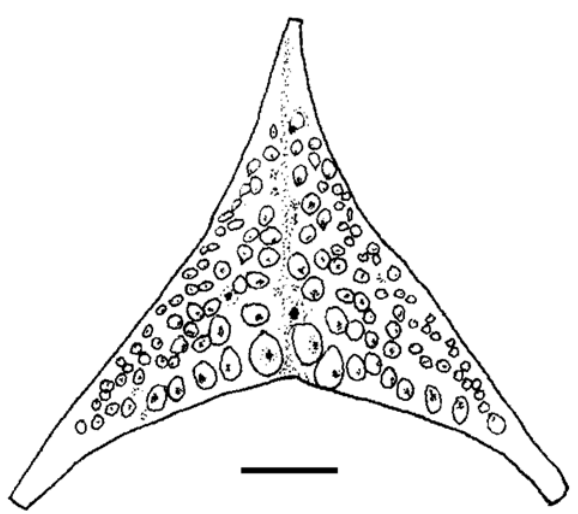
Fig. 9. Crenicichla maculata , lower pharyngeal tooth plate in occlusal aspect, MCP 11257 (133.7 mm